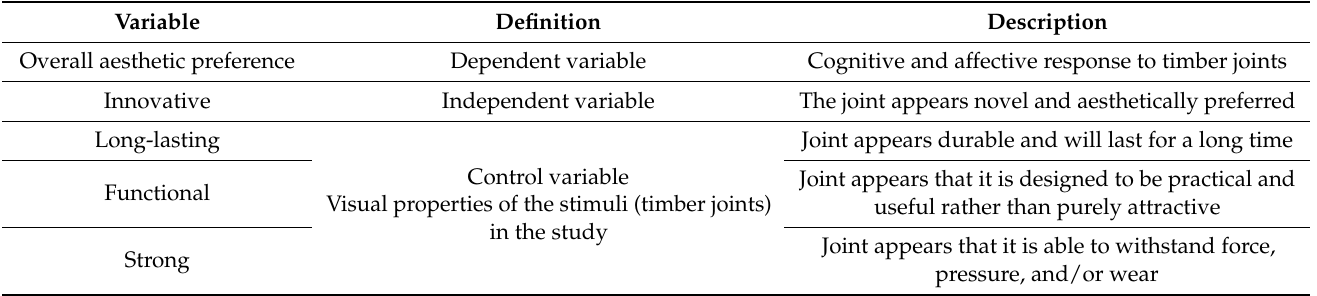
Table 1. Definition and description of all variables used in the